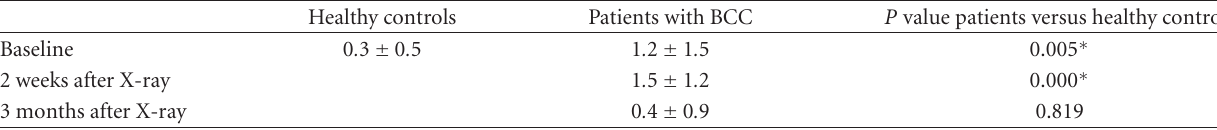
Table 3: Total DLQI scores for patients with 25 BCC baseline and after X-ray therapy and 25 healthy controls matched by gender and age. Healthy controls Patients with BCC